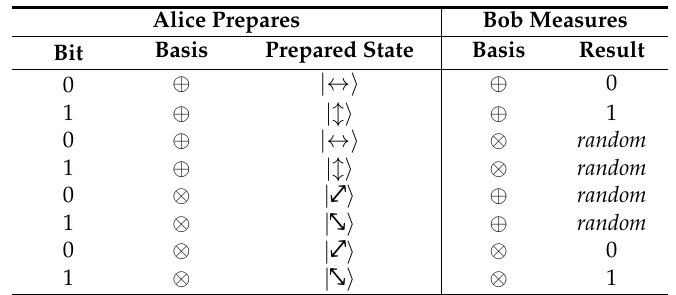
Table 1. Example BB84 Protocol.